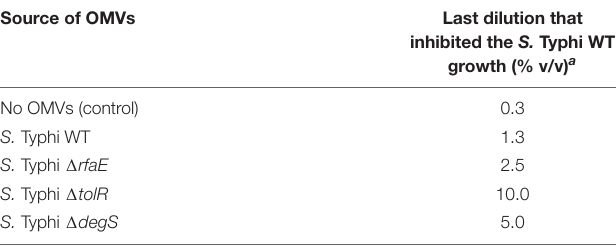
TABLE 2 | Bioassay to determine the relative amount of polymyxin B in a solution previously incubated with OMVs extracted from S. Typhi WT or derivatives. Source of OMVs Last dilution that inhibited the S. Typhi WT growth (% v/v)